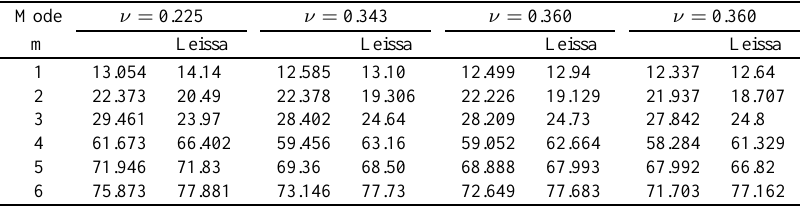
Table 1 Dimensionless frequency parameters λ mn for square plate and different Poisson’s ratios